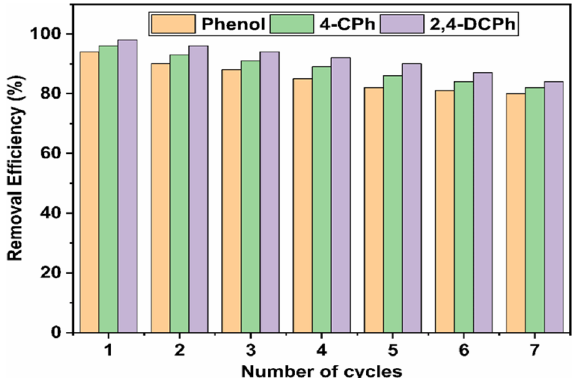
Figure 13. Recycling of WAS-BC biochar for phenol, 4-CPh, and 2,4-DCPh.